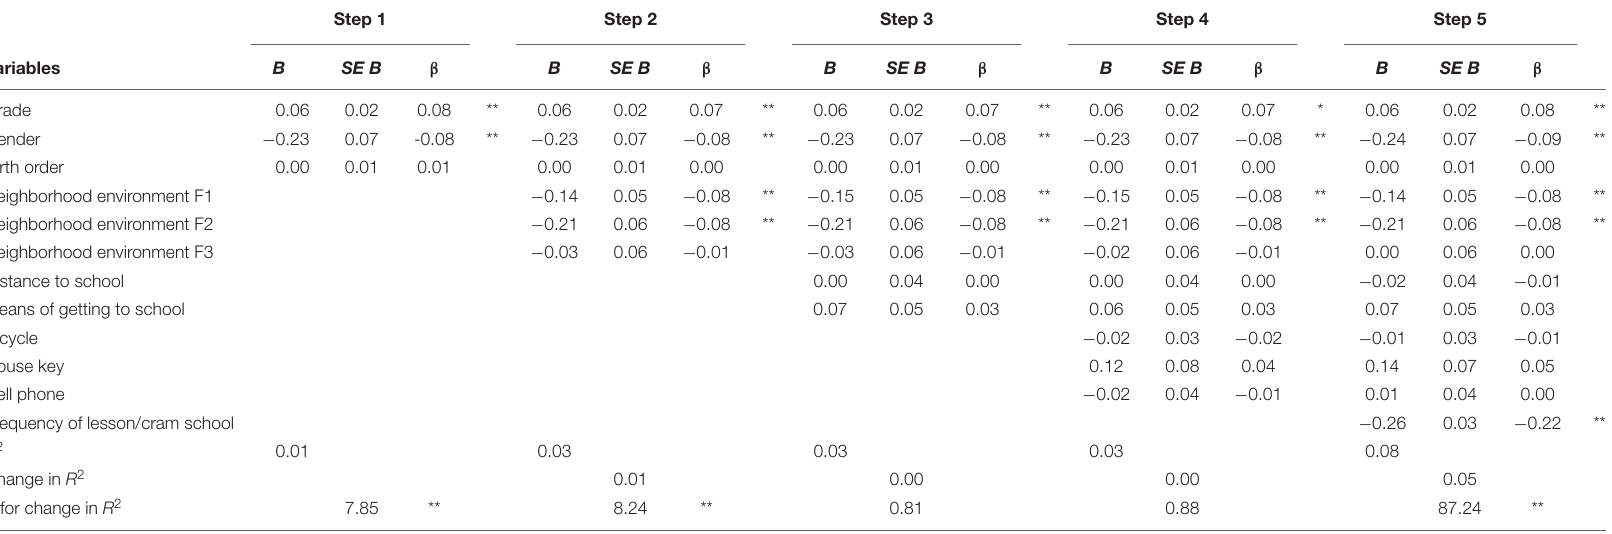
TABLE 10 | Results of hierarchical multiple regression analysis predicting the first factor of children’s independent mobility.